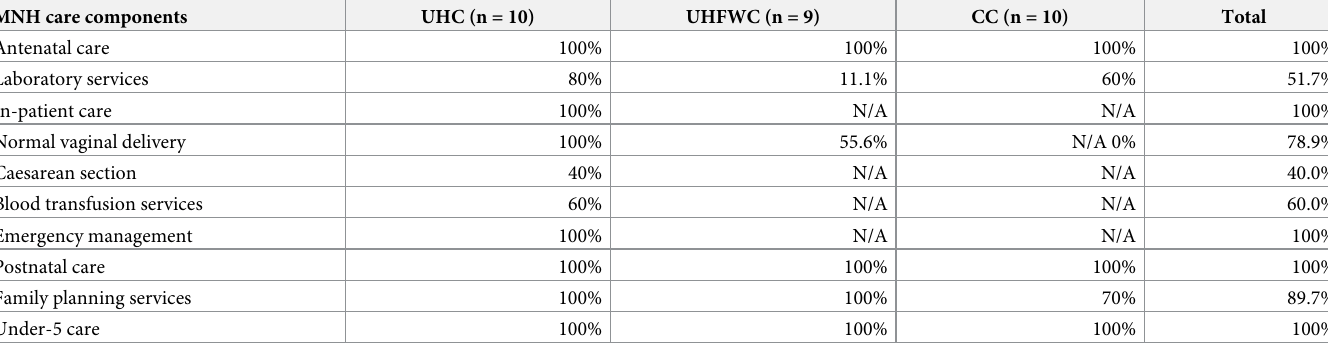
Table 3. MNH care provision in the public health facilities of HtR areas of Bangladesh in percentage. MNH care components Antenatal